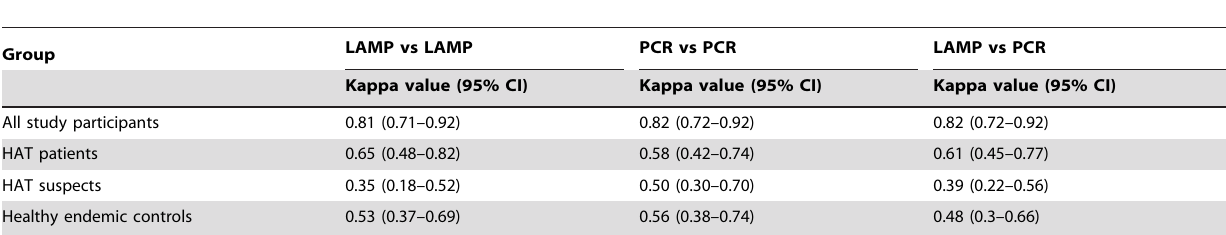
Table 2. Agreement between the two LAMP replicates and between LAMP and